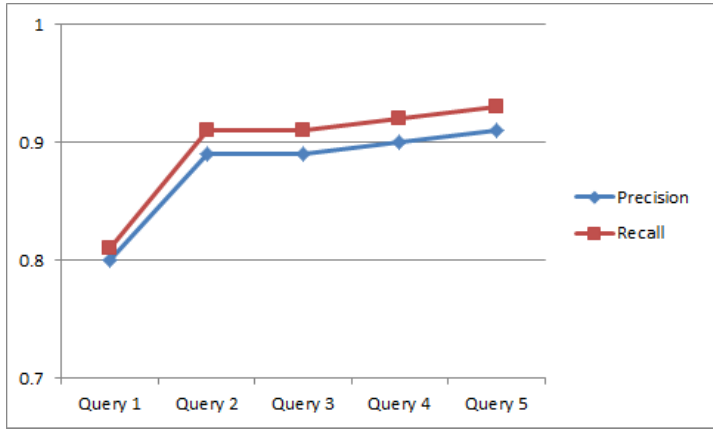
Figure 4. Precision and